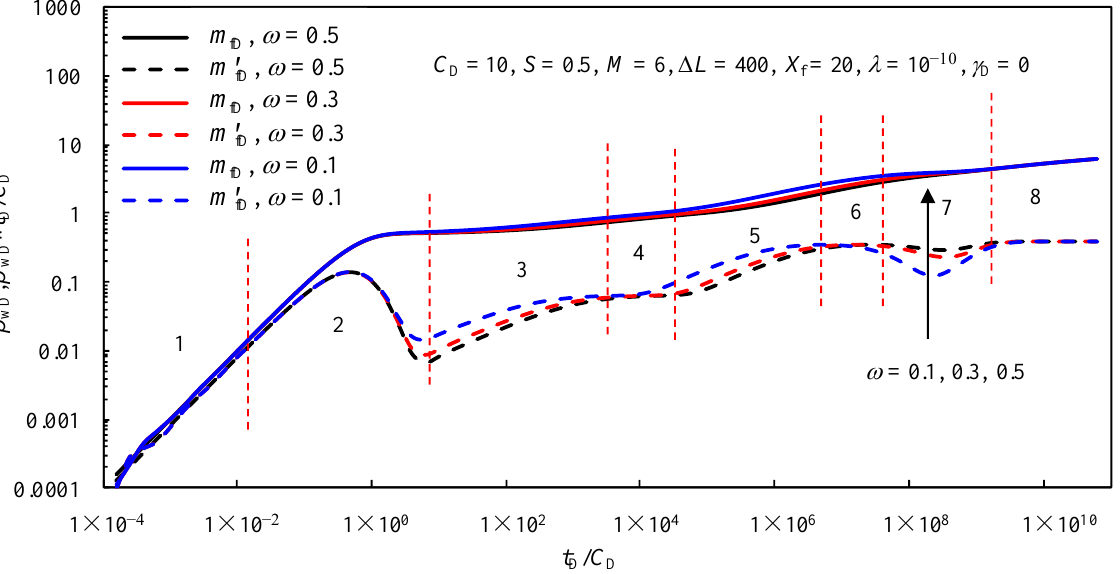
Figure 6. The effect of the storativity ratio on the dimensionless pressure and pressure derivatives of a MFHW in an inter-salt shale oil reservoir.